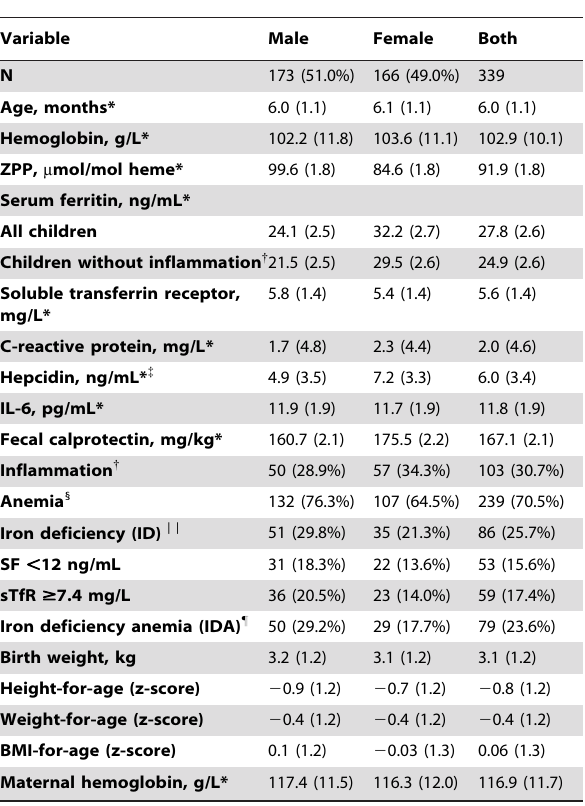
Table 1. Characteristics of the study